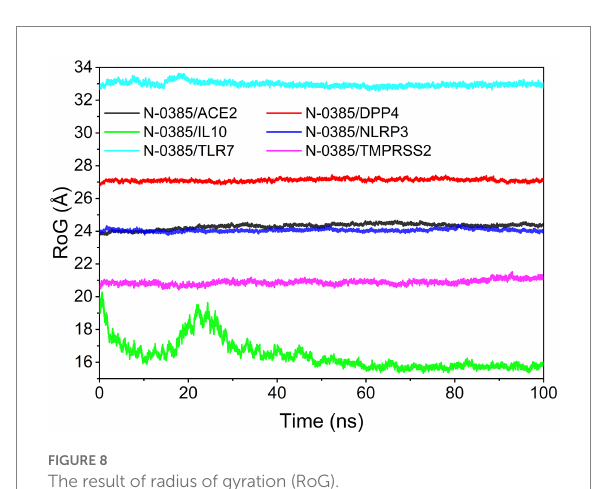
FIGURE 8 The result of radius of gyration